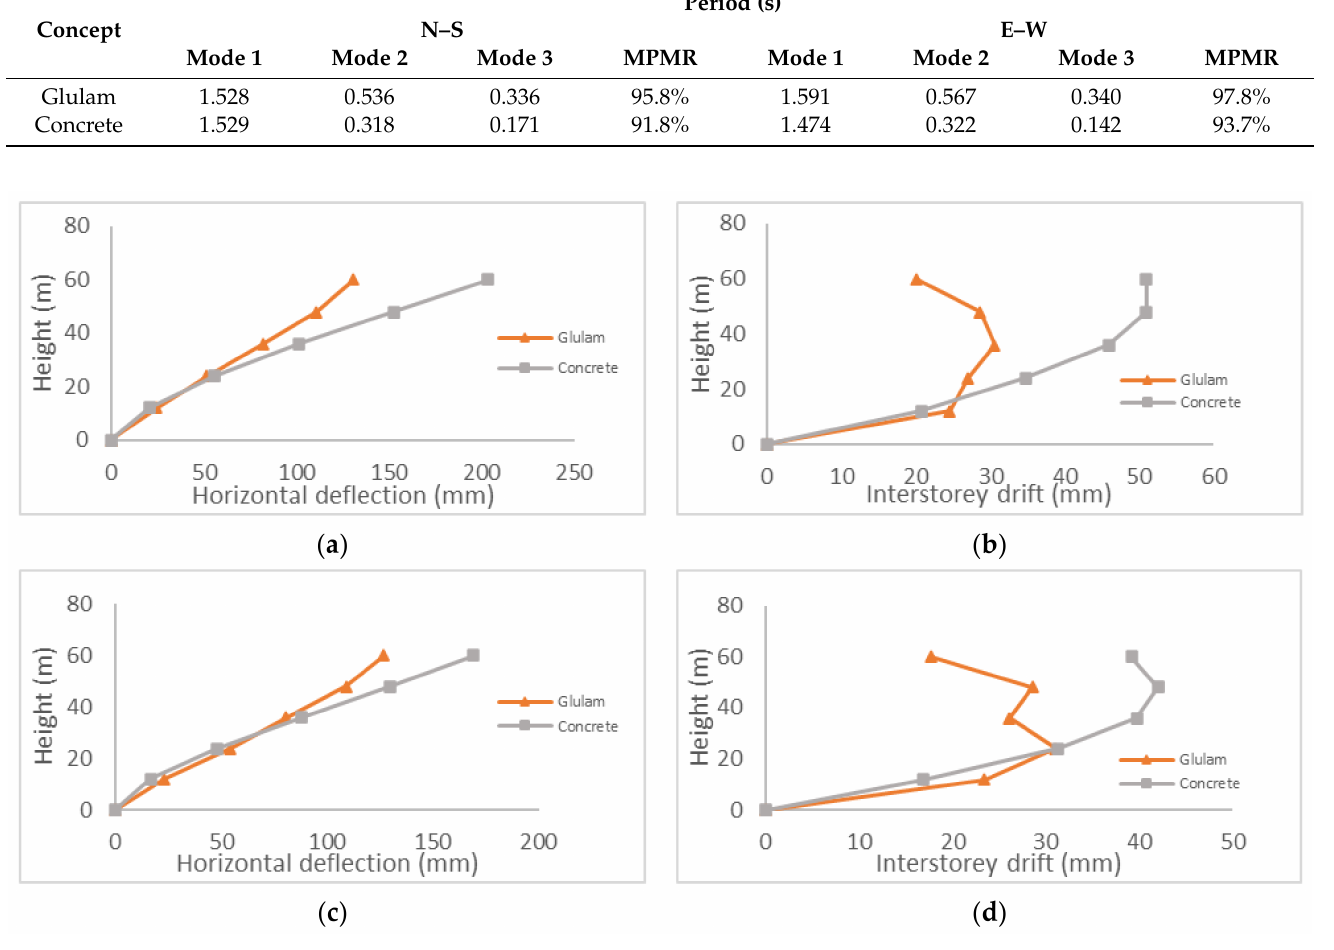
Figure 6. Total horizontal deflections (( a ) N–S direction ( c ) E–W direction) and interstory drifts (( b ) N–S direction ( d ) E–W direction) associated with seismic forces. Total deflections and interstory drifts under wind loads are presented in Figure 7a–d. Under wind loads, the glulam hyperstructure experienced bigger deflections and drifts than the concrete hyperstructure, but the maximal interstory drift was never higher than 25% of the limit drift ratio of H/500 prescribed by the